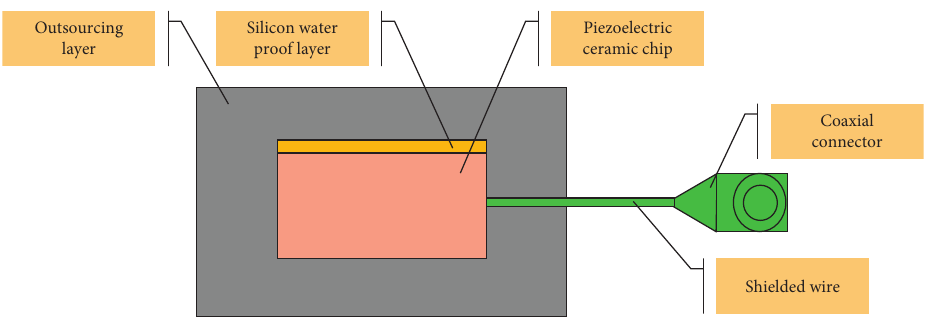
Figure 5: Piezoelectric sensors setup in